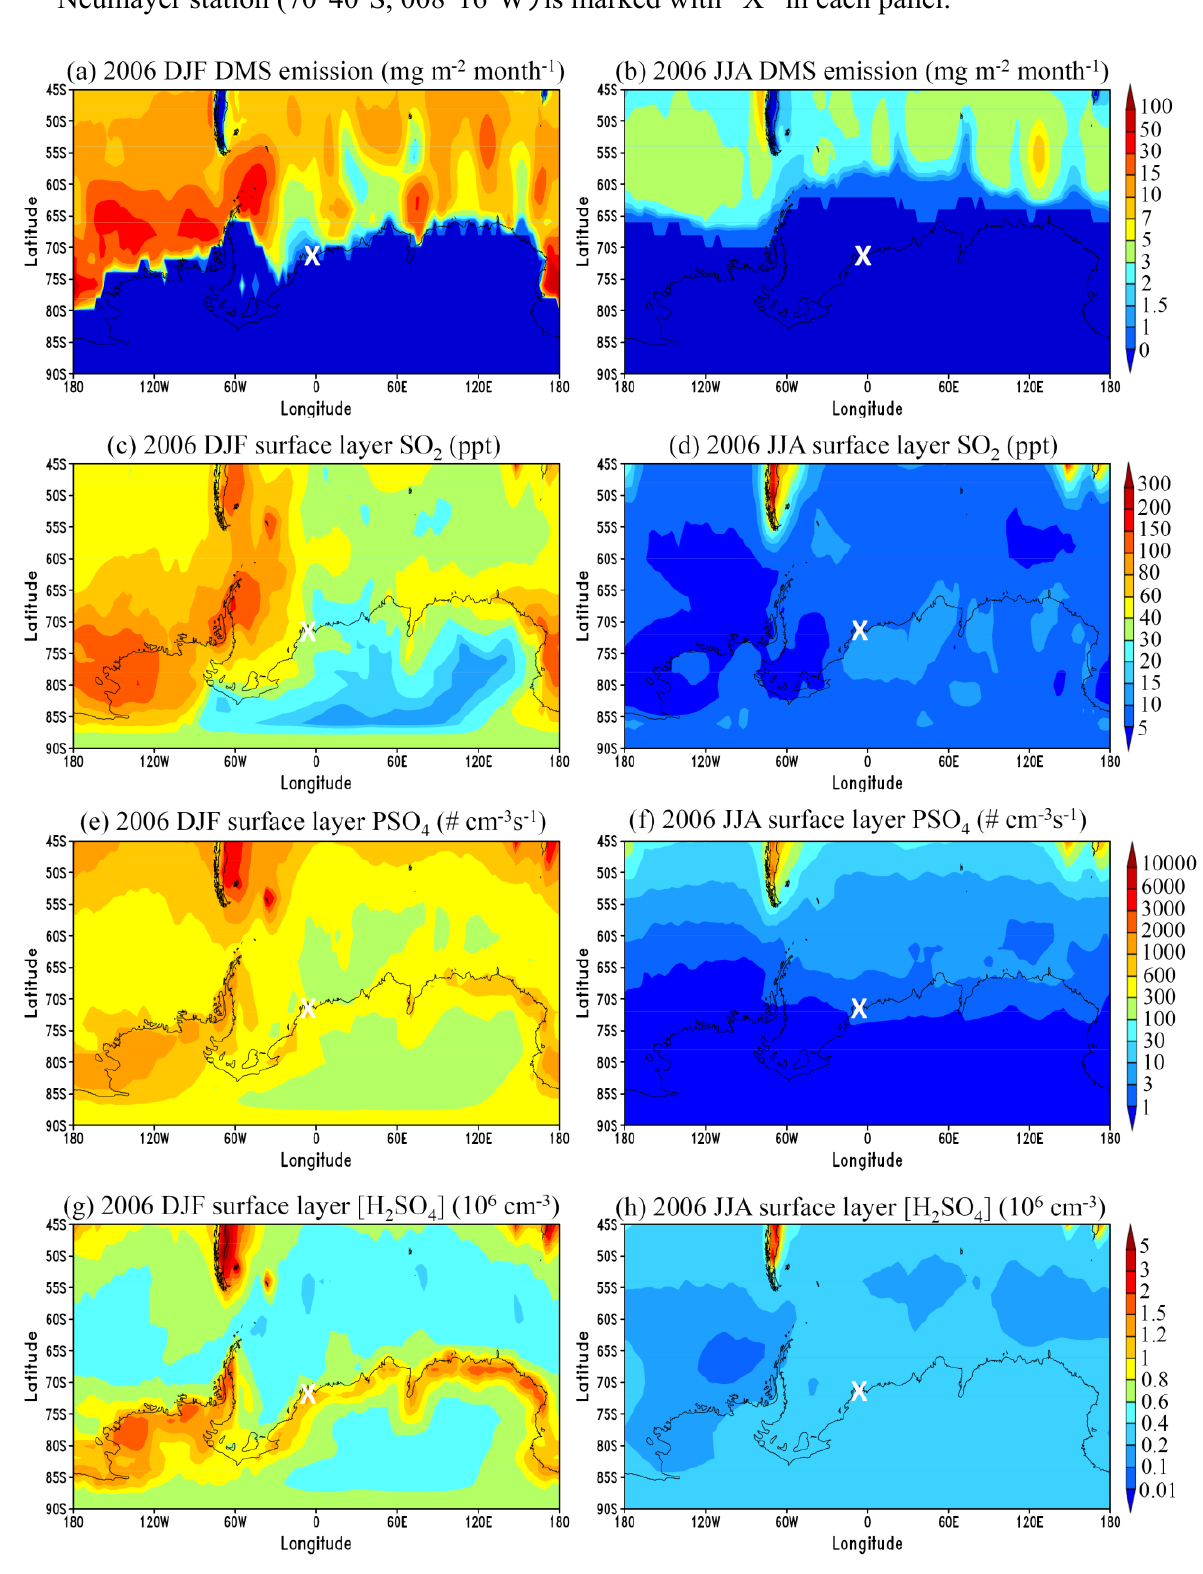
Figure 1. Simulated seasonal averages of (for year 2006) DMS emission rate, SO concentration ([SO ]), H SO gas photochemical production rate (P 2 2 4 concentration ([H SO ]) during the austral summer (DJF) and winter (JJA) seasons in the 2 4 surface layer over Antarctica and surrounding oceans. The location of the German Neumayer station (70°40’S, 008°16’W) is marked with “X” in each